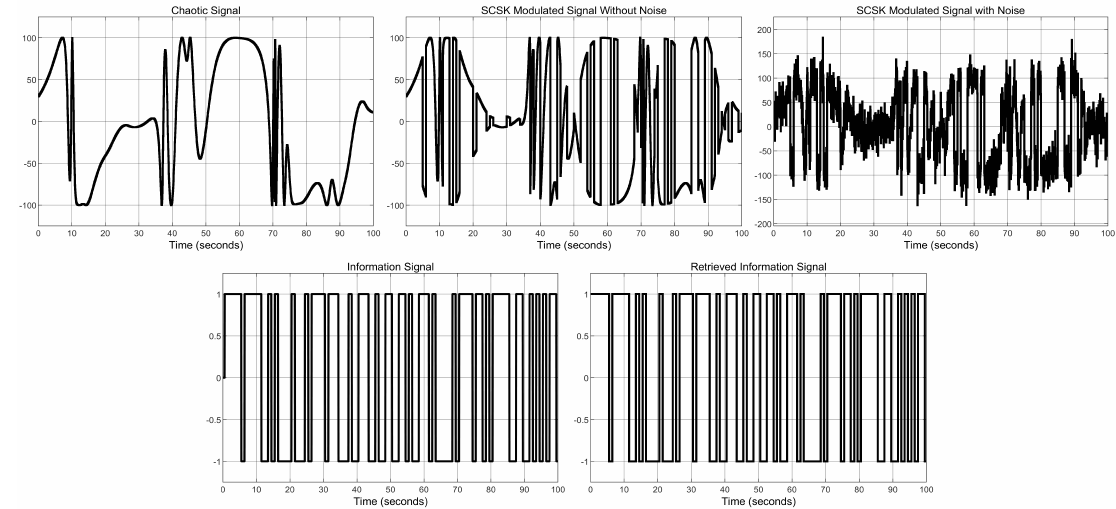
Figure 11. Simulation results of the SCSK secure communications design, for chaotic signal 100 · sin ( x + y + z )